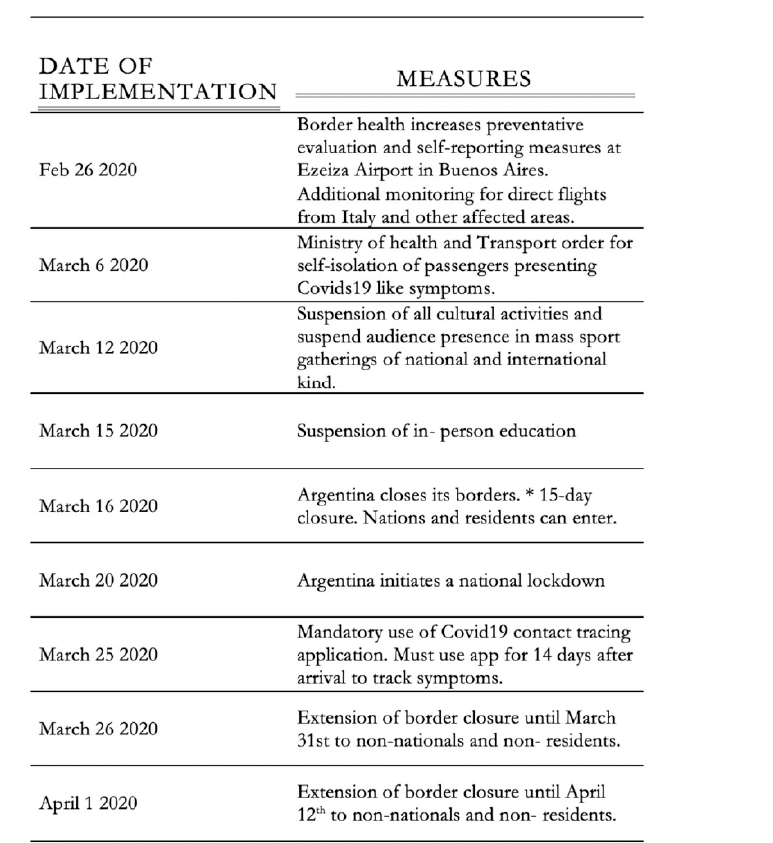
Figure 10. Timeline of non-pharmaceutical interventions [34].